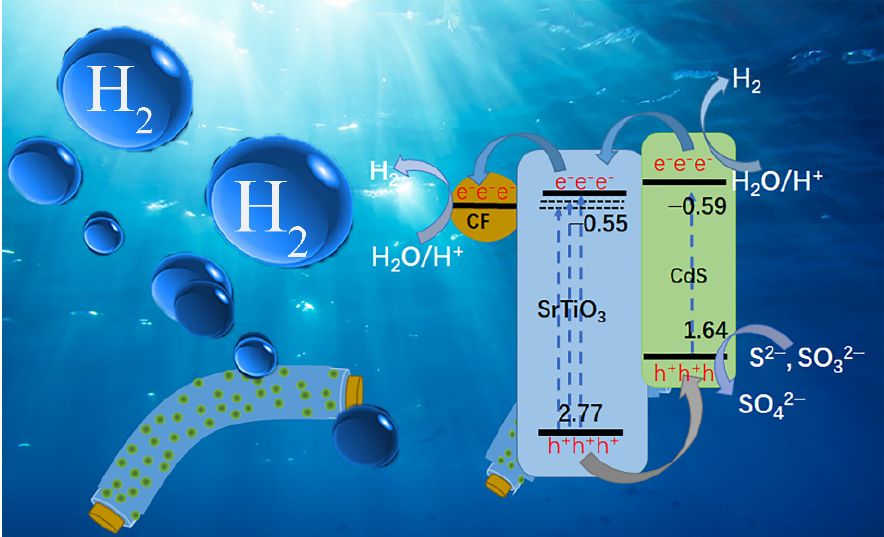
Figure 14. Photocatalytic hydrogen production mechanism of CF/SrTiO 3 /CdS.